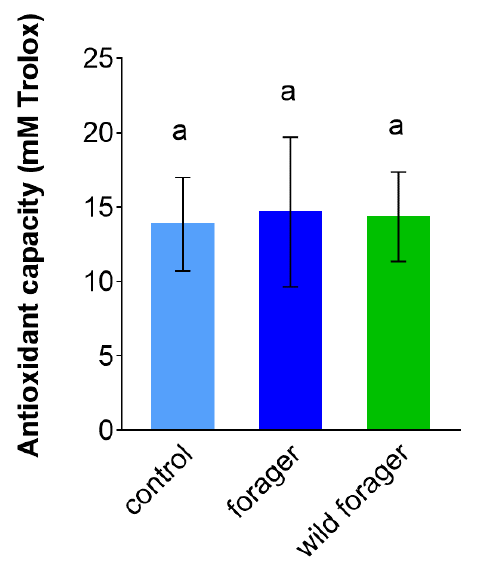
Figure 3. The antioxidant capacity determined in the pooled hemolymph samples from non-foraging control, foraging and wild Bombus terrestris workers ( n = 3–4; five animals per biological replicate which means at least 15 bumble bee workers per each group). The concentration of antioxidants was quantified using the standard antioxidant Trolox. Data presented as mean ± SD; significant differences p < 0.05 are indicated by different letters above the columns (Dunn’s test).